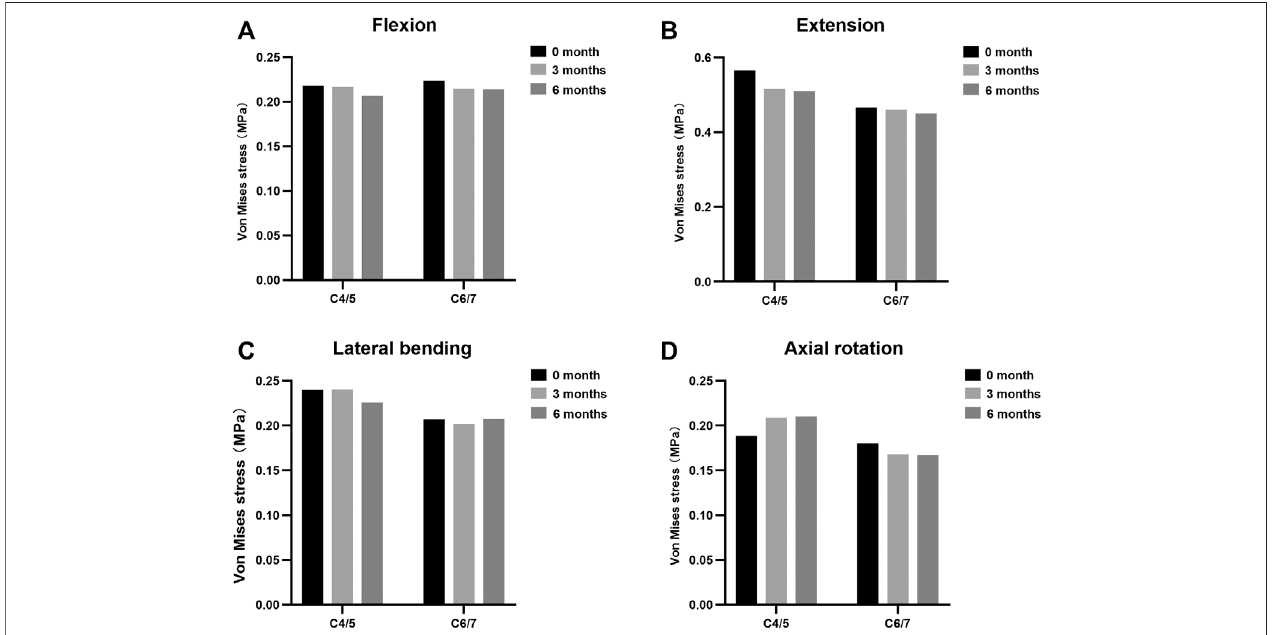
FIGURE 3 | Maximal Von Mises stress at adjacent levels during different fusion courses in (A) fl exion, (B) extension, (C) lateral bending, and (D) axial rotation.